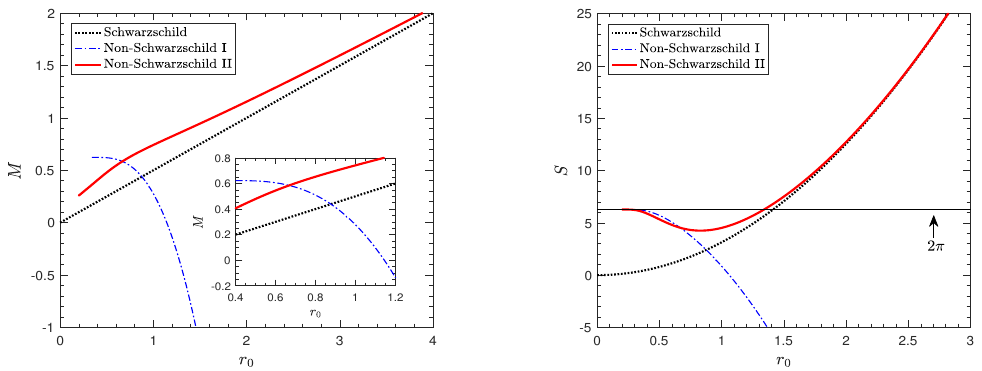
Figure 5 . The ADM mass (left panel) and entropy (right panel) as functions of r 0 . Curves are marked in the same style as in figure 3. The inset in left panel displays masses of different solutions around intersection